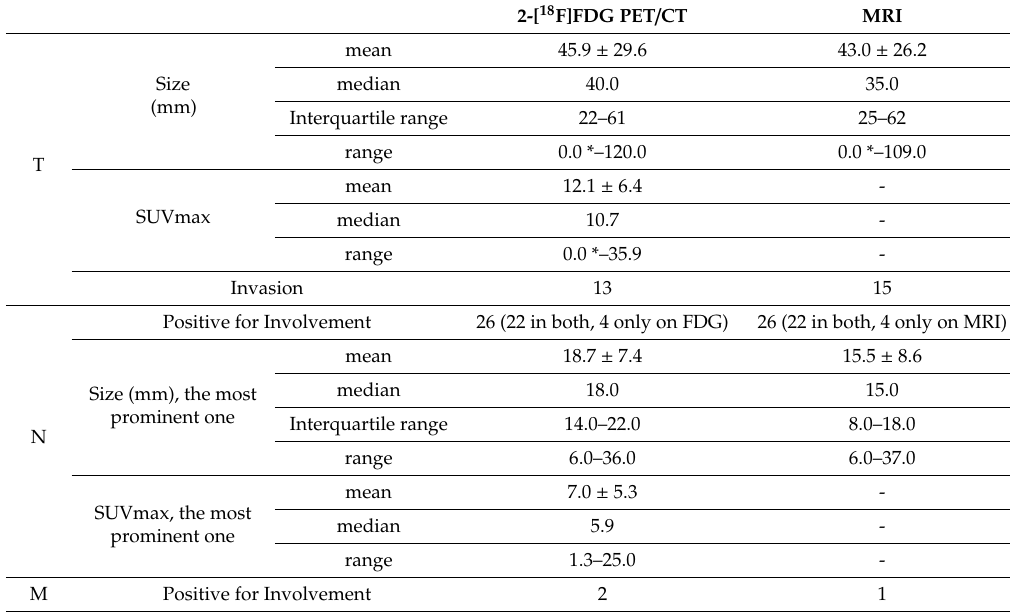
Table 3. Detected lesions on 2-[ 18 F]FDG PET / CT and MRI. 2-[ 18 F]FDG PET /